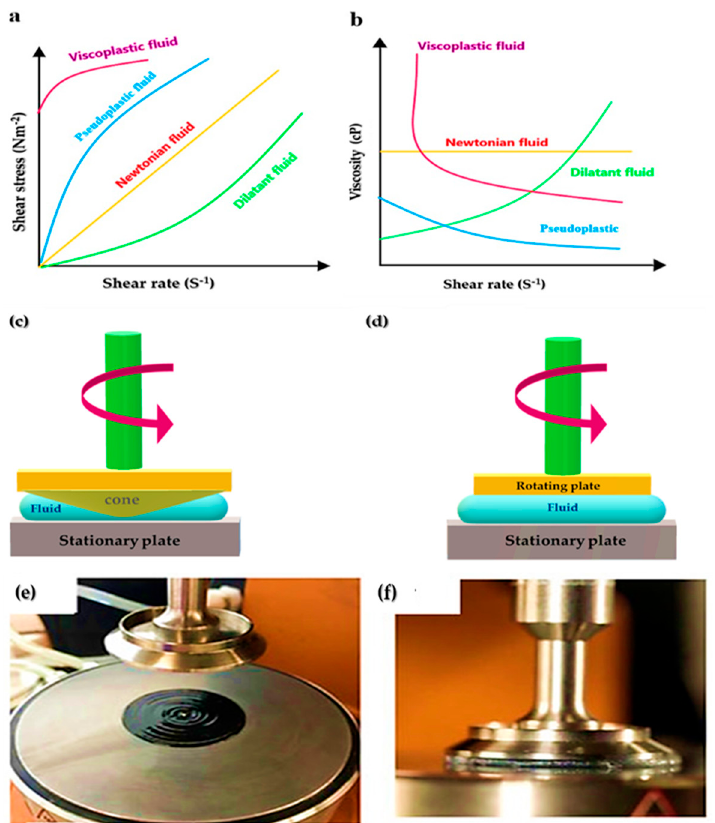
Figure 6. ( a ) Shear stress and shear strain flow curves for different fluids and ( b ) viscosity profiles for different fluid systems ( c ) Schematics (not to scale) of CTP and ( d ) PTP viscometers. Photograph of a PTP setup preparing for measurement with ( e ) plate retracted and ink loaded and ( f ) plate down on an ink sample, reprinted with permission from